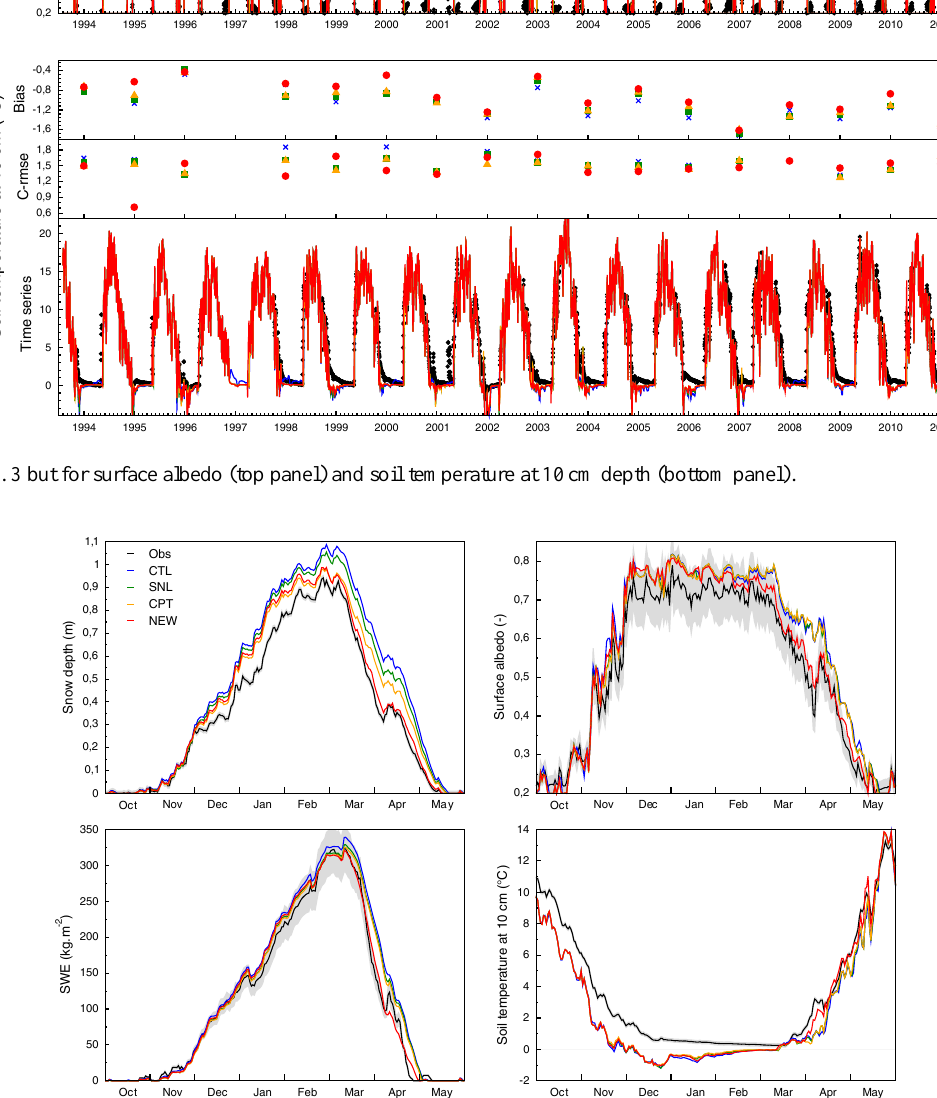
www.the-cryosphere.net/10/853/2016/ The Cryosphere, 10, 853–877,